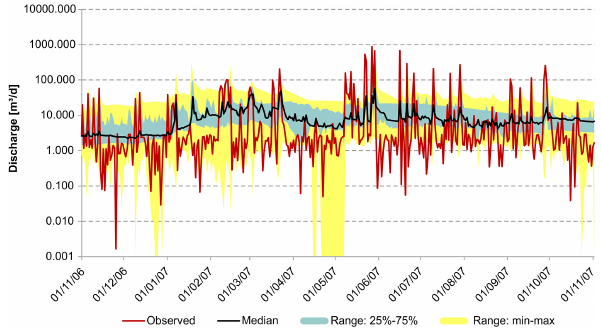
Figure 5. Discharge predicted for the hydrological year 2006/2007 (second